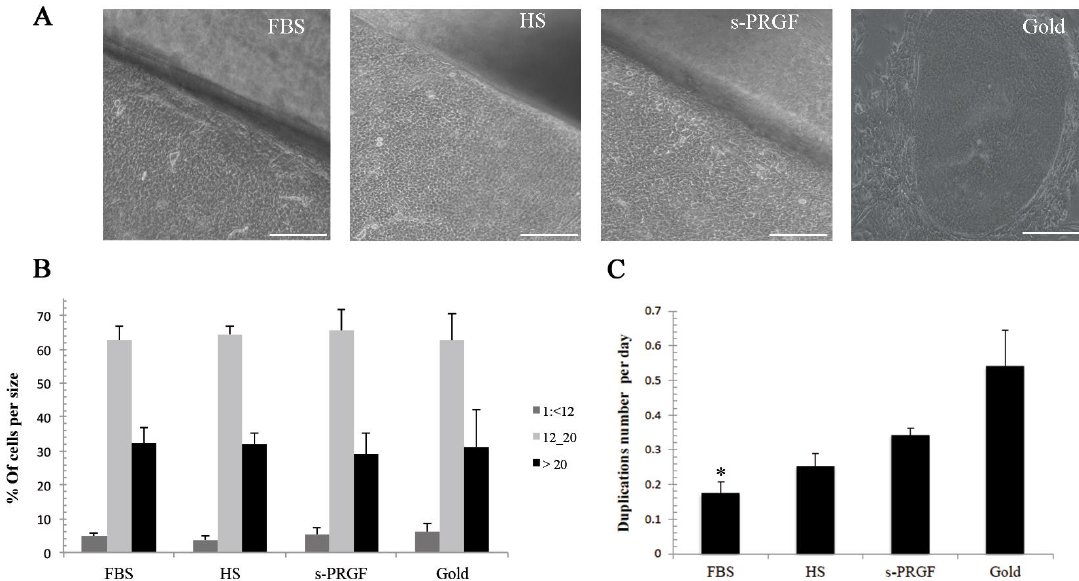
Figure 1. LESCs cultured following the gold standard or explants culture methodologies with FBS or human HS and s-PRGF sera: ( A ) Phenotype of cell cultures; ( B ) Percentage of cells corresponding to each cell size; ( C ) Cell growth rate represented as the number of cell duplications per day. * Indicates significant differences between the gold standard culture and the indicated treatment. (* p < 0.05). Scale bar in phase-contrast microscopy images, 100 micrometers. LESCs: limbal epithelial stem/progenitor cells; FBS: fetal bovine serum; HS: human serum; s-PRGF: serum derived from plasma rich in growth factors.